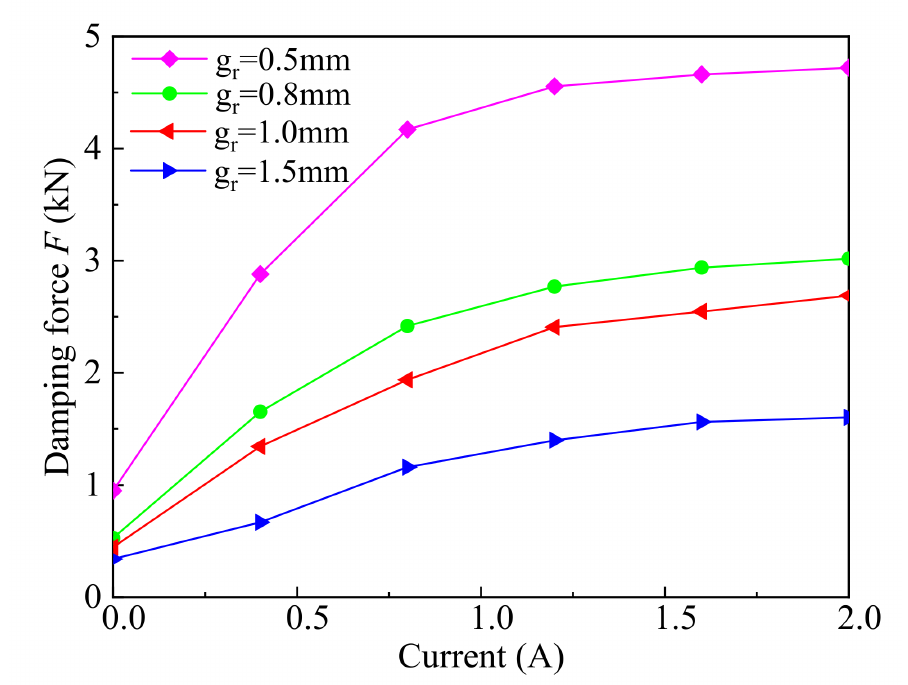
Figure 22. The experimental damping force versus the current under different radial damping